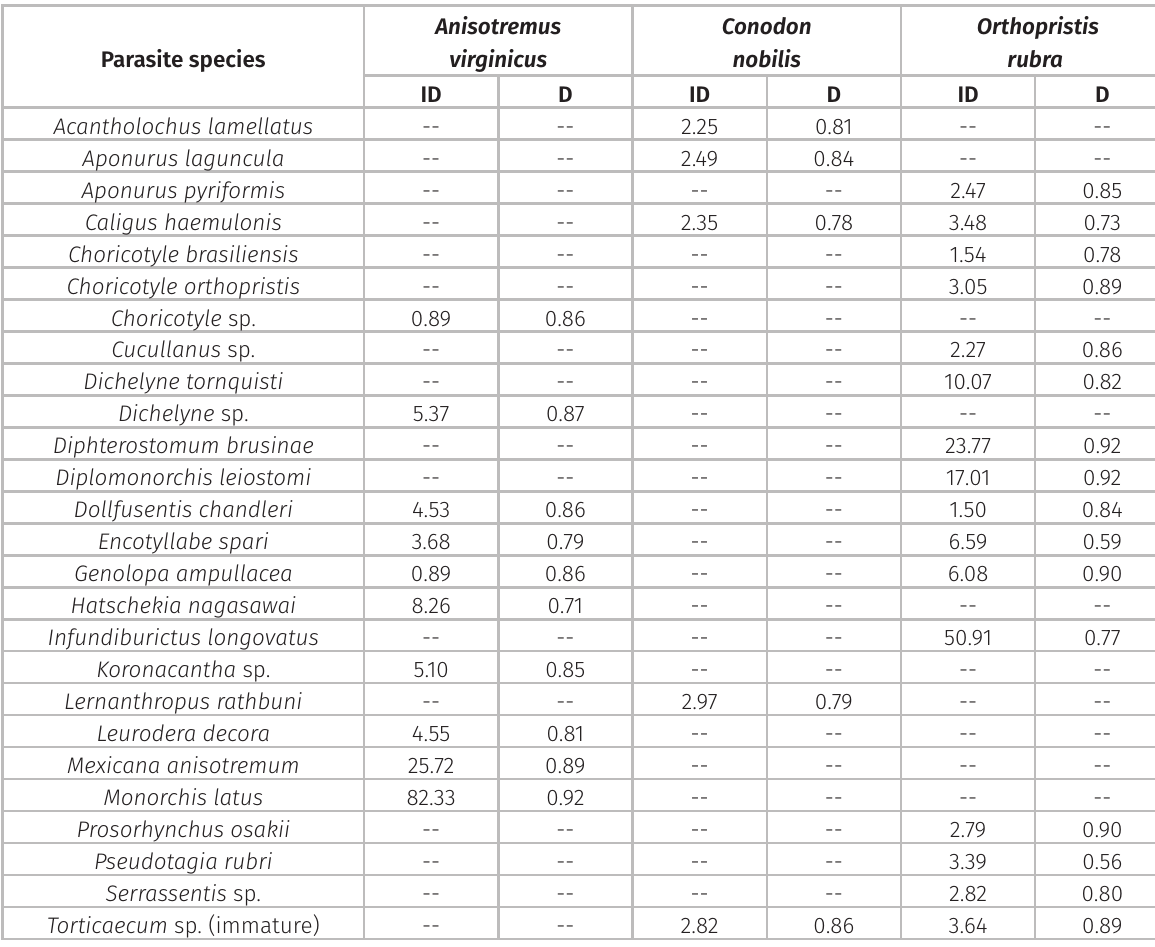
Table II. Values of variance-to-mean abundance ratio (ID) and index of Discrepancy (D) of metazoan parasites of Anisotremus virginicus , Conodon nobilis and Orthopristis rubra from the coastal zone of Rio de Janeiro,